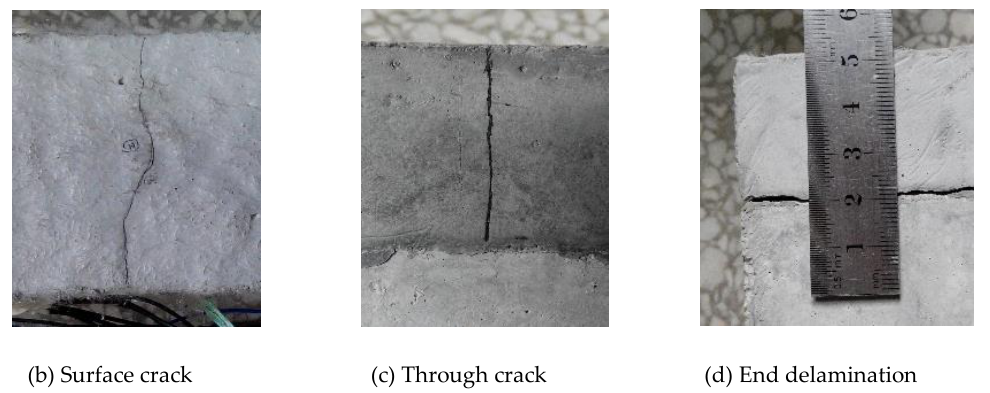
Figure 11. Typical crack formation and interfacial delamination patterns of SHCC-repaired concrete beam.